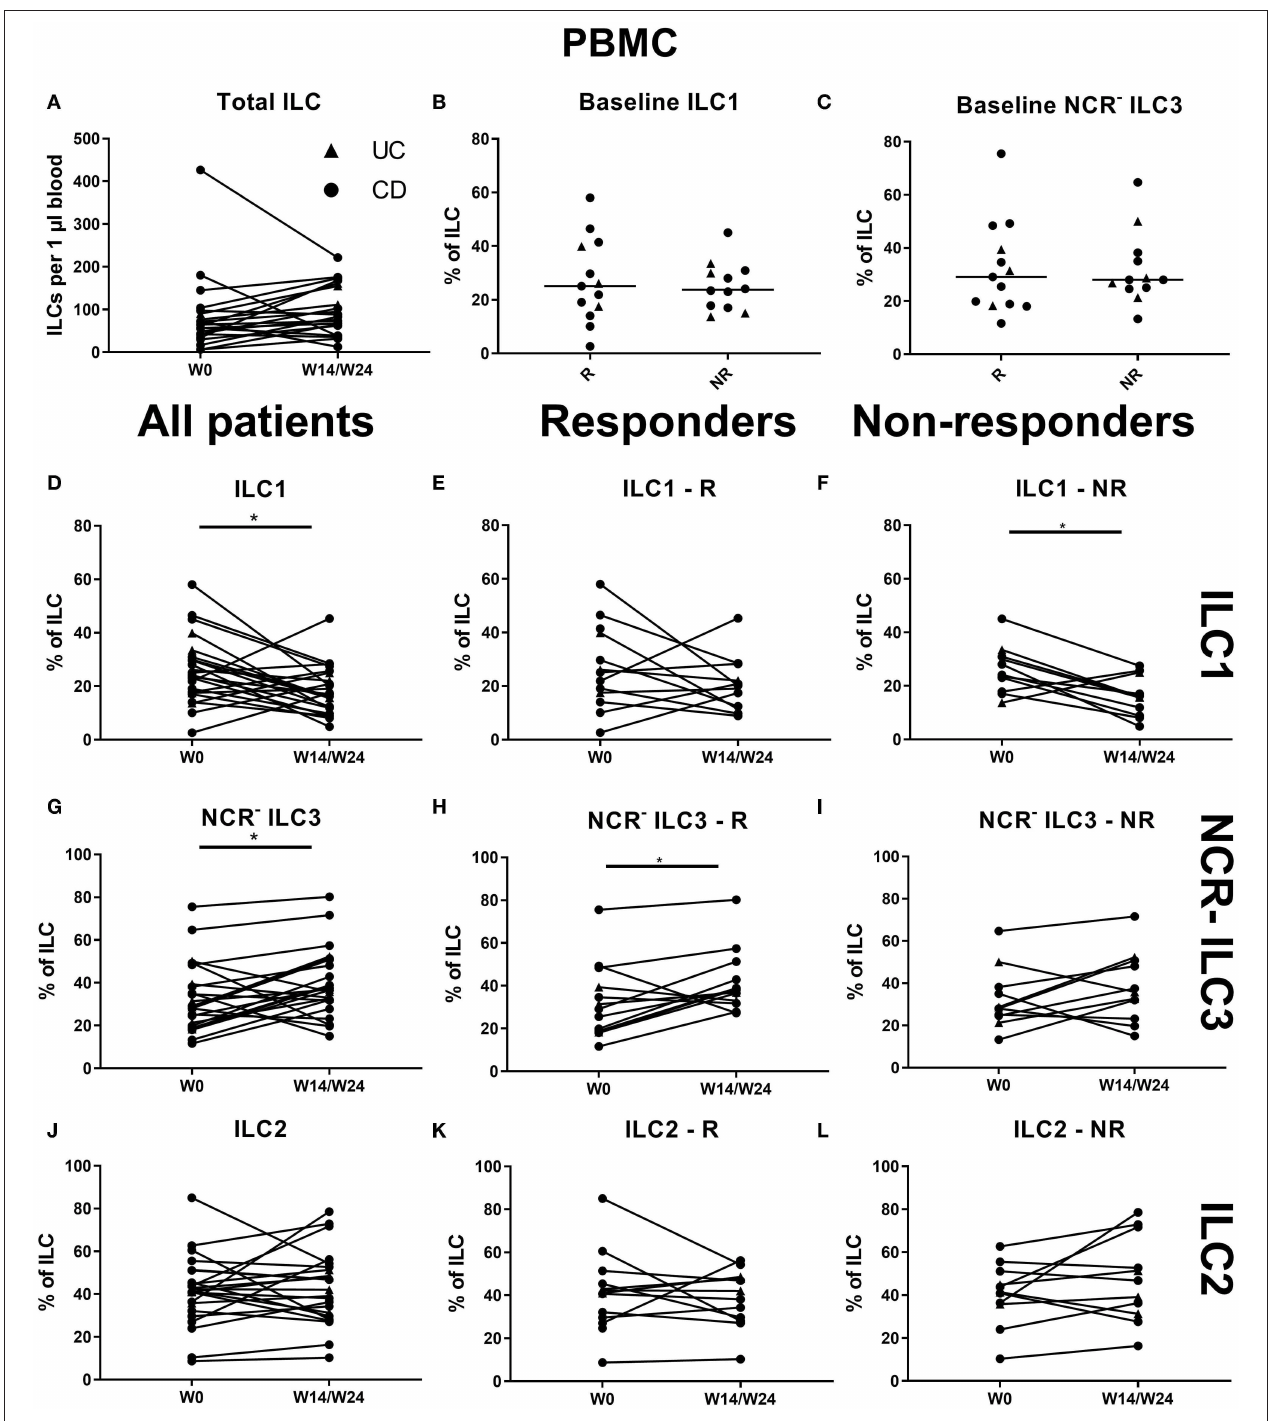
FIGURE 6 | Effect of anti-TNF treatment on ILC and ILC subsets in blood. Twenty-five patients initiating anti-TNF treatment were followed up for 14 (UC, 1 )/24 (CD, • ) weeks and subdivided into responders (R, n = 13) and nonresponders (NR, n = 12) based on endoscopic evaluation. Total ILC numbers expressed per microliter of blood in all patients (A) . Baseline ILC1 (B) and NCR − ILC3 (C) levels in R and in NR. Follow-up of circulating ILC1 in all patients (D) , in R (E) and in NR (F) . Follow-up of circulating NCR − ILC3 in all patients (G) , in R (H) and in NR (I) . Follow-up of circulating ILC2 in all patients (J) , in R (K) and in NR (L) . Mann–Whitney U testing (B,C) ; Wilcoxon paired-match testing (A,D–L) ; * p < 0.05. NCR, natural cytotoxic receptor; ILC, innate lymphoid cell CD, Crohn disease; UC, ulcerative colitis.